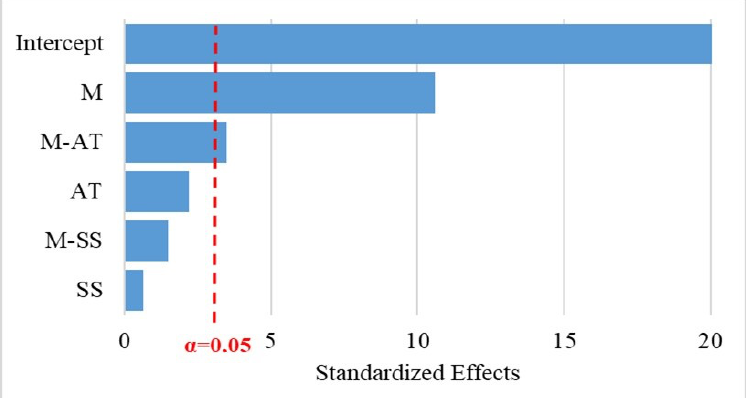
Figure 5. Standardized Pareto Chart for Shore D Hardness.